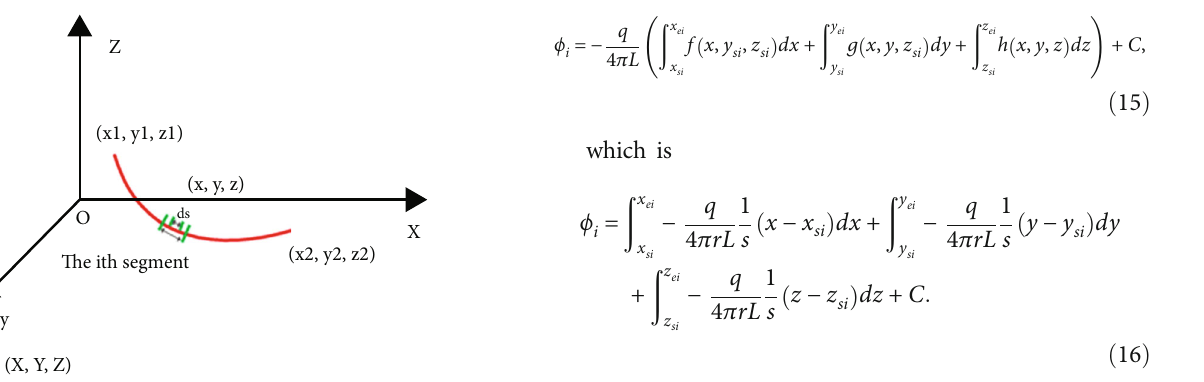
Figure 1: Schematic diagram of horizontal wells in unbounded strata.